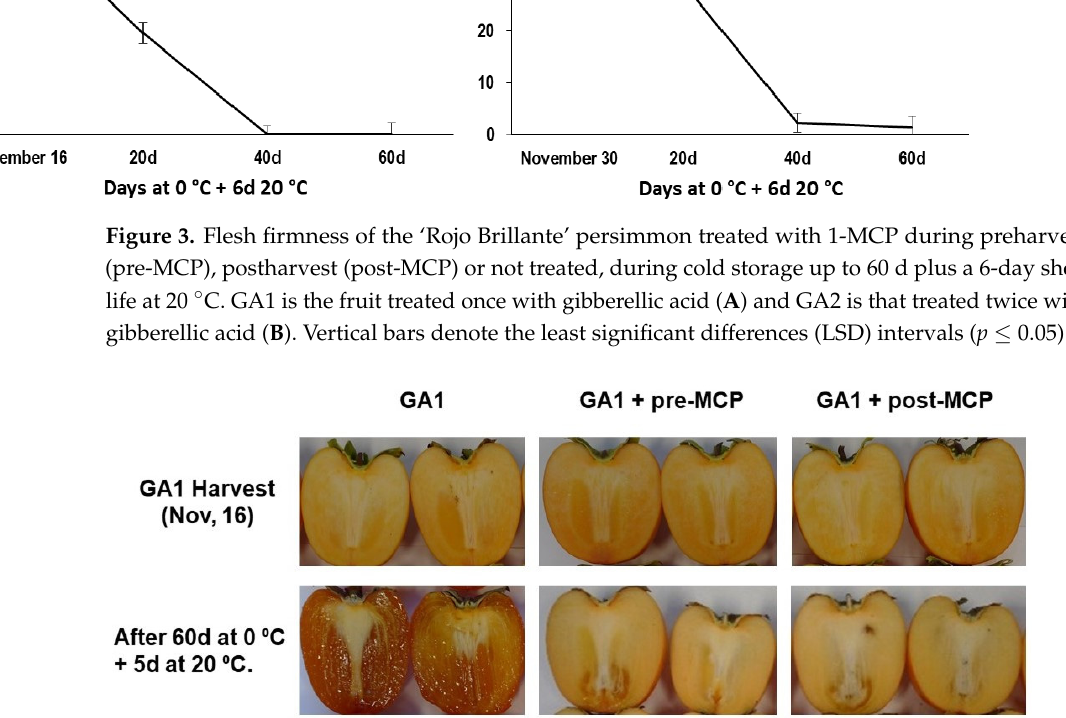
Figure 4. Captured images of ‘Rojo Brillante’ persimmon treated once with gibberellic acid (GA1) at harvest moment (on 16 November) and after 60 d at 0 °C plus 6-day shelf life at 20 °C. Fruit was treated with 1-MCP during preharvest (pre-MCP), postharvest (post-MCP) or not treated.